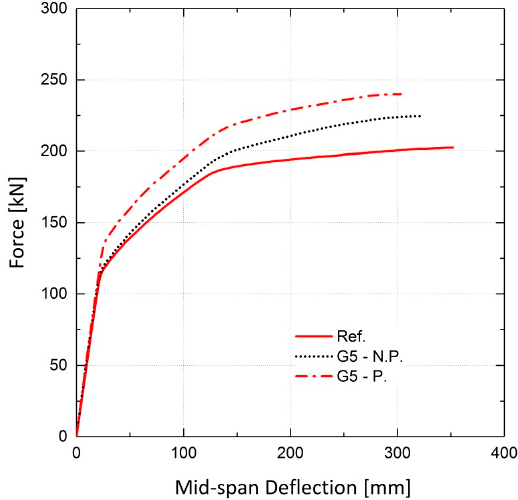
Figure 28. E ff ect of activated and non-activated Fe-SMA bars on load–deflection behavior of Figure 28. Effect of activated and non-activated Fe-SMA bars on load–deflection behavior of G5.